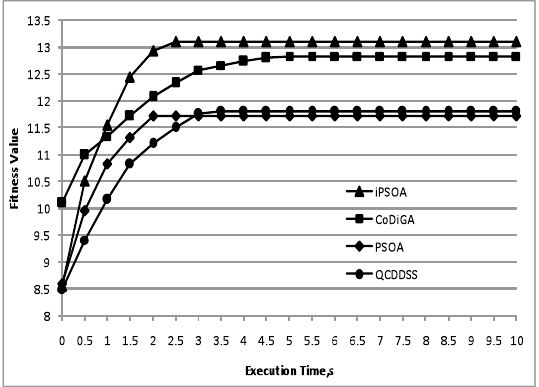
Fig.9 Convergence of fitness for 30 tasks